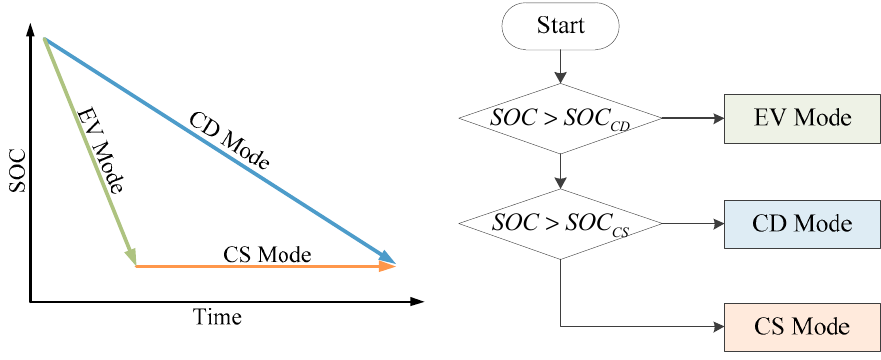
Figure 6. Switching control rules of PHEV working modes.